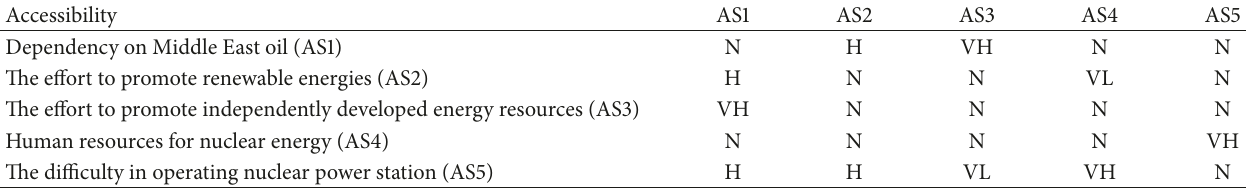
Table 7: Direct-influenced relation matrix using linguistic values for Accessibility (Case 2 ).